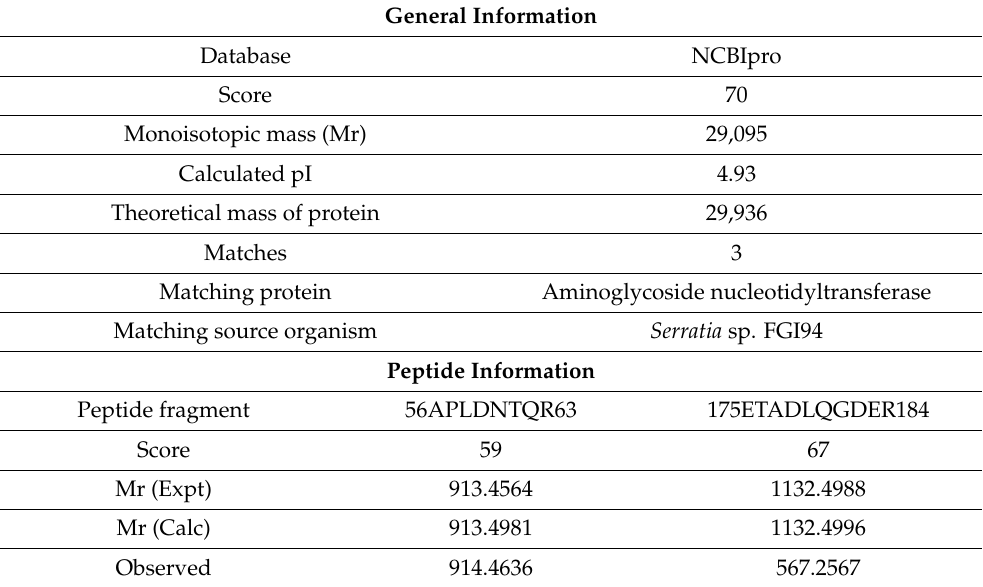
Table 1. Protein identification: MALDI-TOF/TOF mass spectrometry analysis data of trypsin- digested peptides of the targeted protein were matched against data in the Mascot database. Mass information of two peptides of the targeted protein showed a Mascot score of